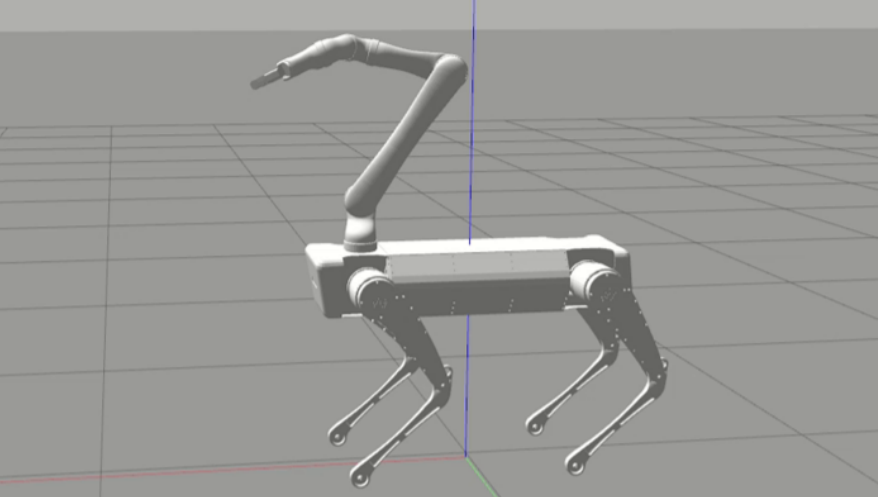
Figure 1. The arm-mounted quadruped robot. The arm has 6 degrees of freedom excluding the